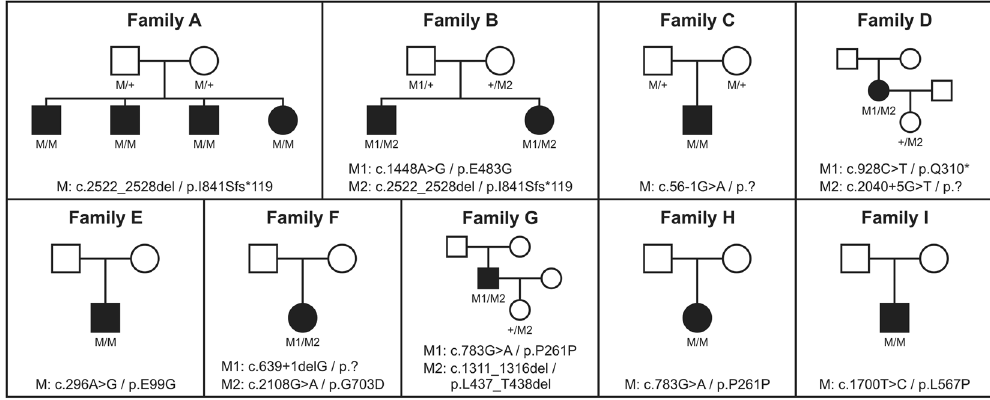
Figure 1. Pedigrees of all families. Disease-causing mutation(s) are given below each pedigree and the genotypes of all available family